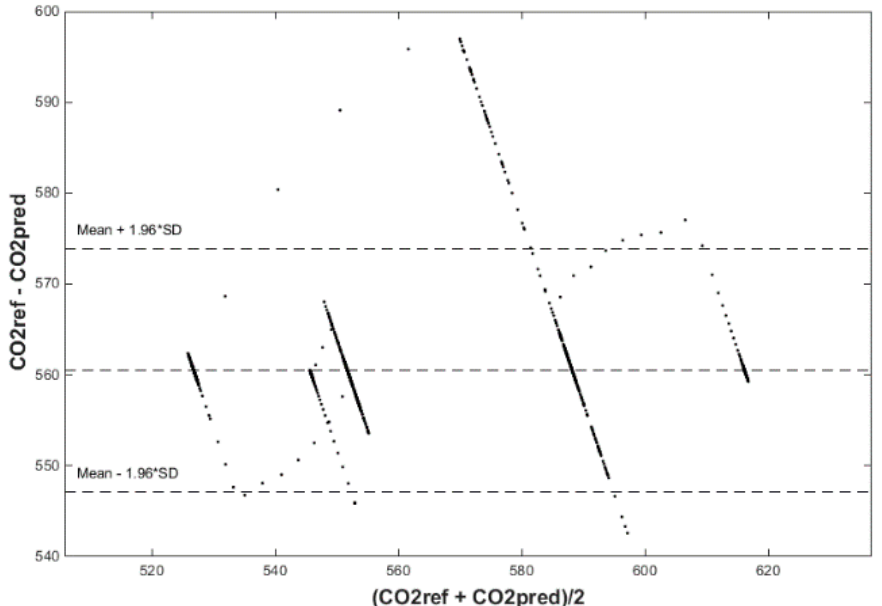
Figure 24. Bland–Altman plot for the reference and predicted CO 2 waveforms (SRLMS AF) from 28 June 2018 in R104 with an ANN with 60 neurons and SCG method trained with data from 25 June 2018 in R203. Table 4. Learned ANN SCG from 25 June 2018 in R203 (with T in and rH in ) and prediction with cross- validation for 26 June 2018 in R104 (with T in and rH in ), 27 June 2018 in R104 (with T in and rH in ), and 28 June 2018 in R104 (with T in and rH in ).